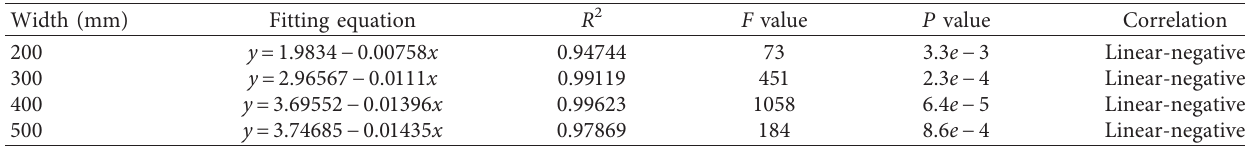
Figure 13: Fitting curves between PCF and width of rock plate. Table 4: Regression analysis results between height and